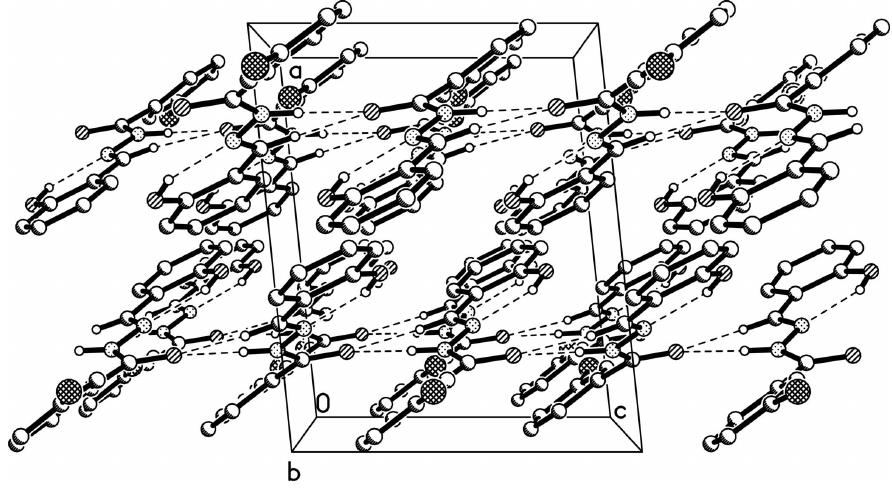
Figure 1 The molecular structure of the title compound, showing 30% probability displacement ellipsoids and the atom-numbering scheme. The dashed line indicates an intramolecular hydrogen bond.